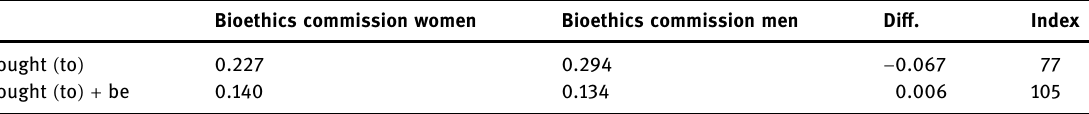
Table 29: Most frequent collocation with “ ought ( to ) , ” as per cent of total tokens ( normalised, n = 1,000 )